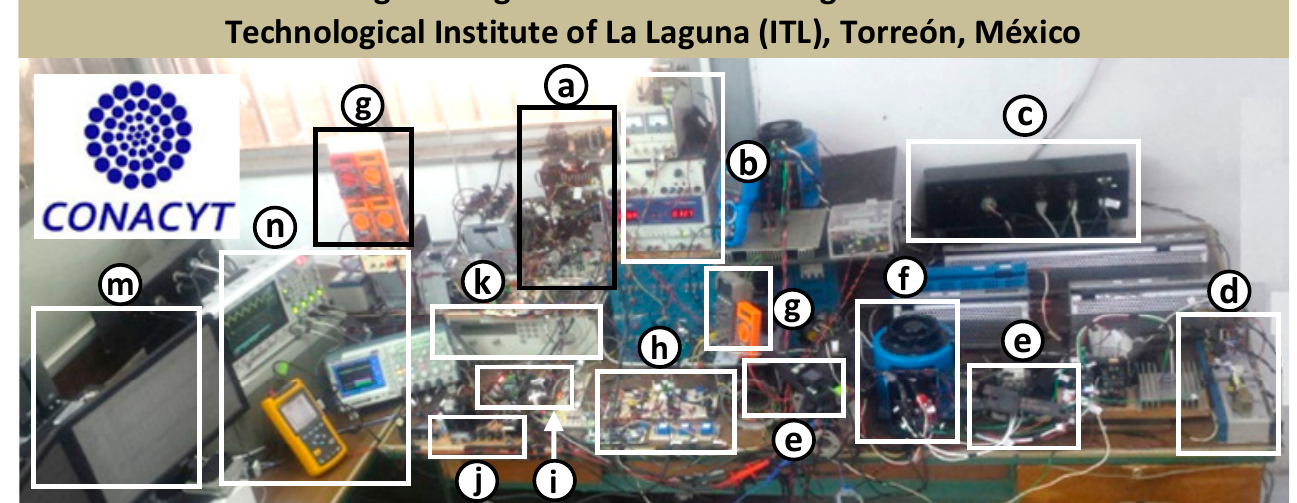
Figure 11. Experimental setup built in the laboratory; ( a ) novel single-phase five-level converter and its drivers; ( b ) auxiliary DC voltage sources; ( c ) grid connectors board; ( d ) line inductor; ( e ) Tektronix Hall current probes; ( f ) grid variable autotransformer; ( g ) multimeters; ( h ) voltage/current Hall sensors and signal conditioning stage; ( i ) DSP/FPGA-based control cards; ( j ) control dashboard; ( k ) Hewlett Packard programmable DC voltage source; ( m ) PC—Windows 10/i7/8 Gb RAM; and ( n ) Tektronix/Agilent digital scopes and Fluke 43B.